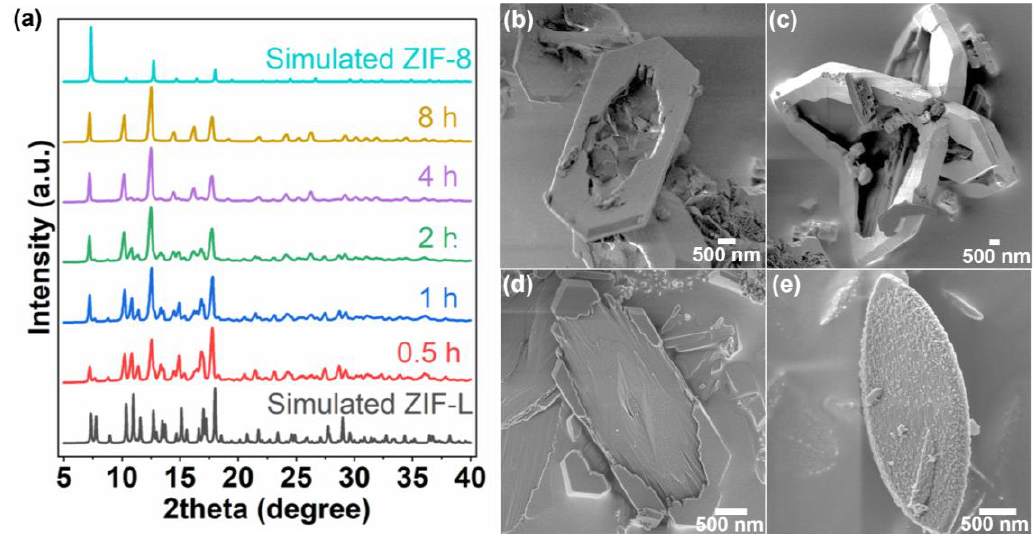
Figure 2. ( a ) XRD patterns of ZIF-L crystals as a function of exposure time (0.5, 1, 2, 4, and 8 h) in a pure solvent (2:1 ( v / v ) DMAc/H 2 O) at 333 K, SEM images of ( b ) leaf-shaped, and ( c ) cross-leaf shaped ZIF-L after the pure solvent (DMAc/H 2 O = 2:1 v / v ) exposure, SEM images of leaf-shaped ZIF-L upon 8 h exposure to ( d ) 1:8( v / v ) DMAc/H 2 O, and ( e ) 8:1( v / v ) DMAc/H 2 O solvent. Table 1. Summary of pH as a function of the DMAc/H 2 O